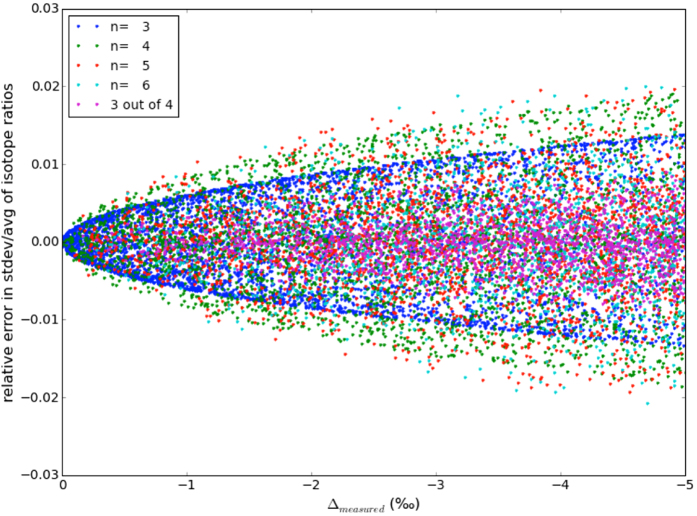
Relative difference of the heterogeneity (relative standard deviation) of the isotope ratios of indistinguishable atoms calculated using Eq. 38 from the true heterogeneity of the randomly chosen sets of isotope ratios.For each multi-isotope system, the outer envelope of the points gives the error within which the heterogeneity of indistinguishable atoms in a certain multi-isotope system can be calculated from the apparent statistical isotope clumping signal Δ.